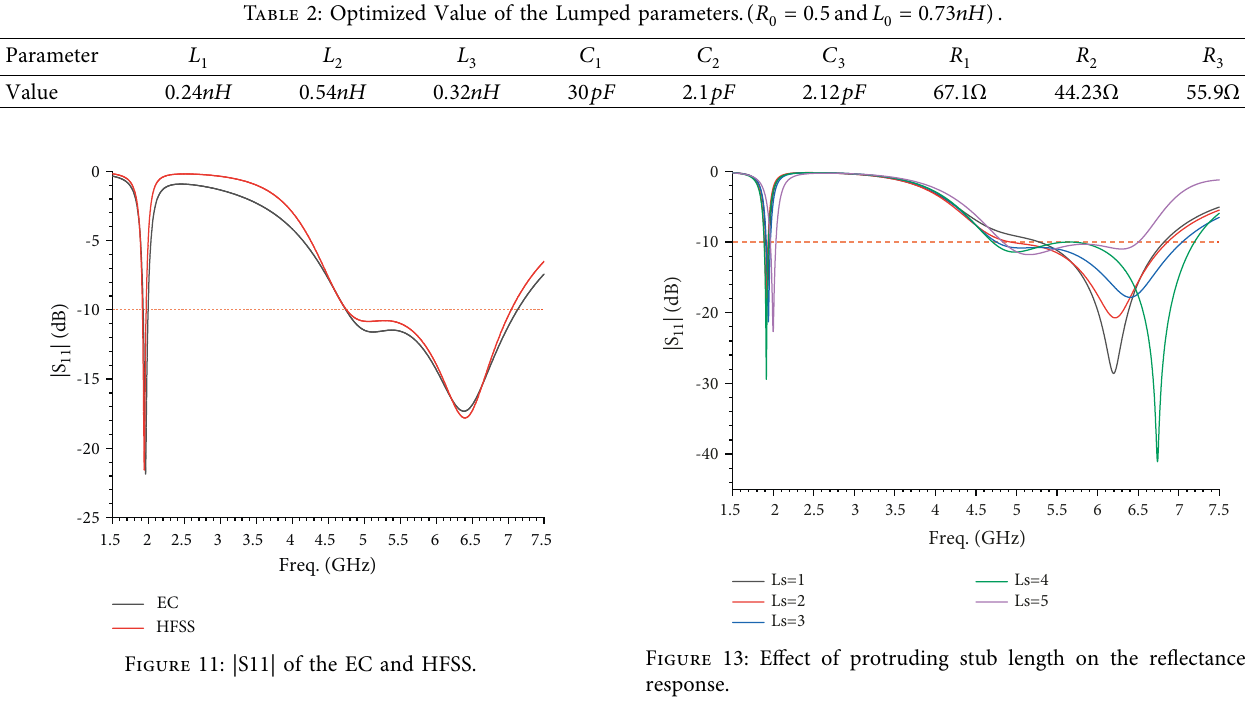
Table 2: Optimized Value of the Lumped parameters. ( R